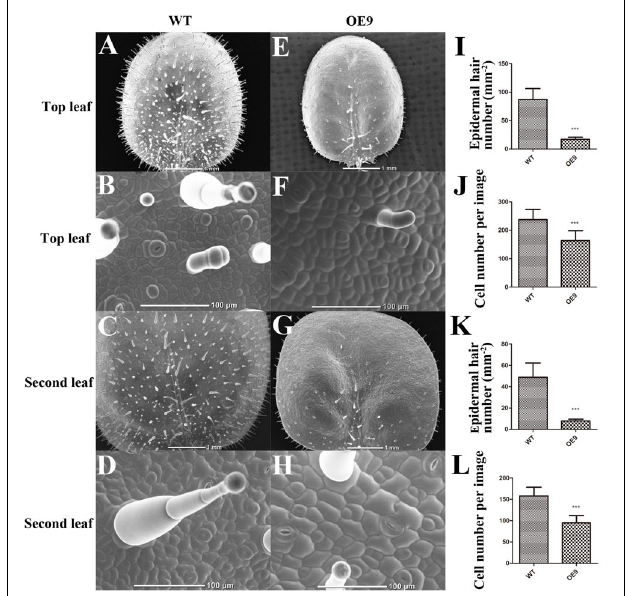
FIGURE 4 | Scanning electron microscope (SEM) observation and calculation of the leaves. SEM observation of adaxial leaves of WT and OE9. (A,E) Top leaf. (C,G) Second leaf. (B,F) The enlargement of (A,E) , respectively. (D,H) The enlargement of (C,G) . The epidermal hair number per mm 2 of the top (I) and second leaves (K) and the average cell number per image of the top (J) and second leaves (L) were calculated. Scale bar: 1 mm in (A,C,E,G) and 100 µ m in (B,D,F,H) . For (I–L) , the values represent the mean ± SD from 10 separate plants of WT and OE9 and the statistically significant differences were evaluated by Student’s t -test ( ∗∗∗ P -value < 0.001).